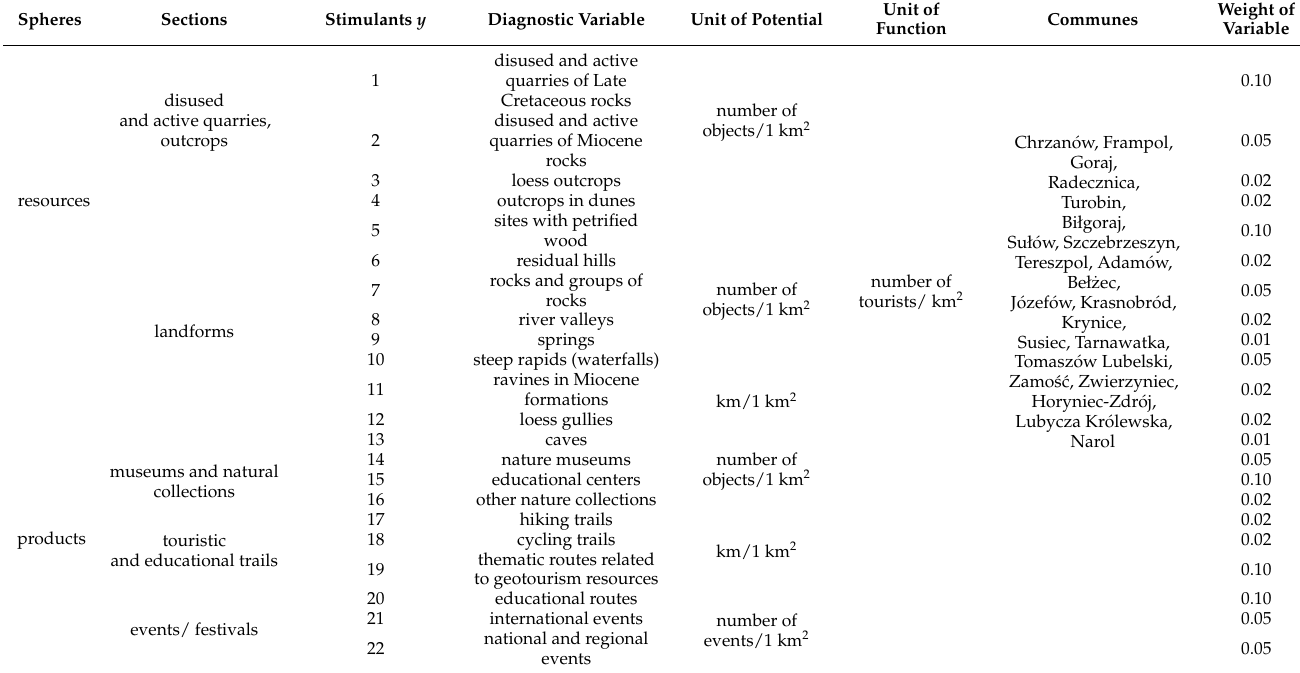
Table 1. Diagnostic variables of the potential and function grouped into spheres and sections with adopted measures and weight